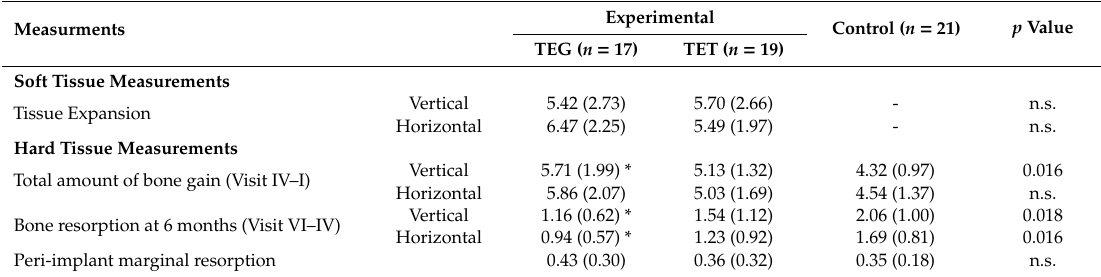
Table 2. The mean di ff erence in soft and hard tissue